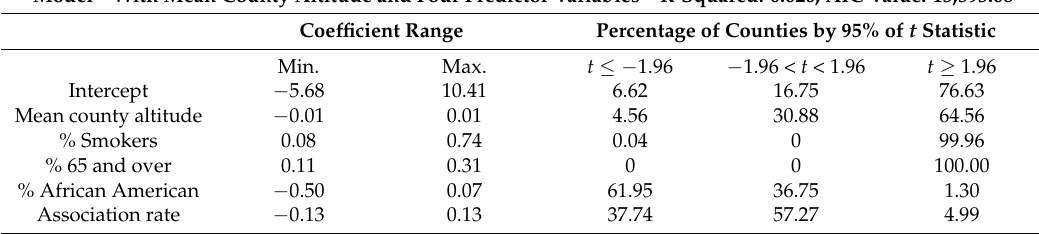
Table 5. Partial results from the GWR model.